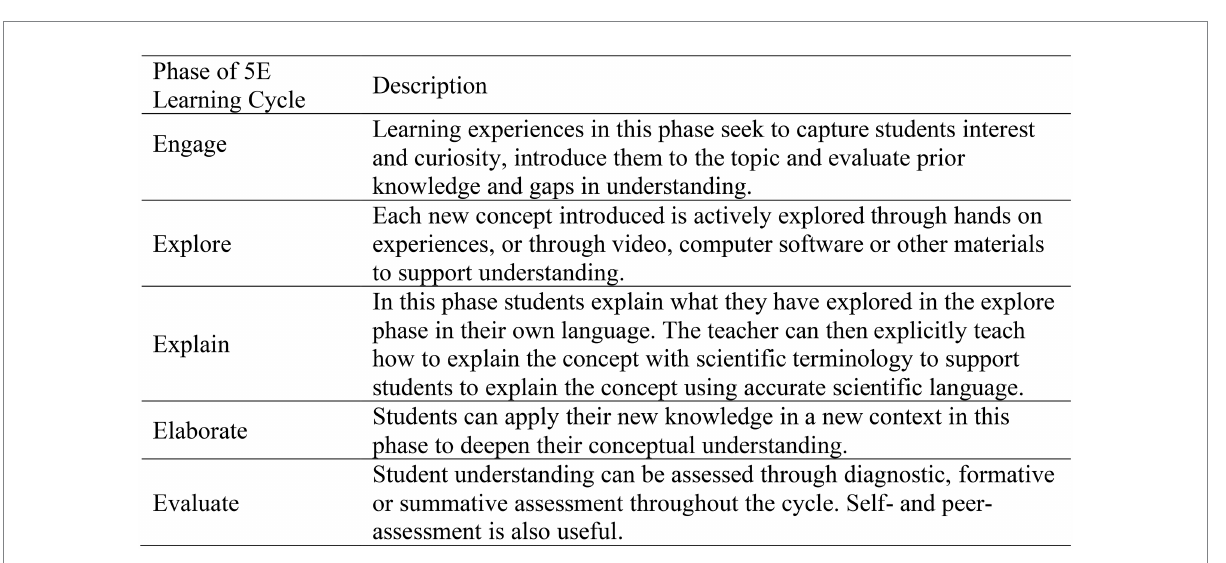
FIGURE 3 Description of the 5E’s